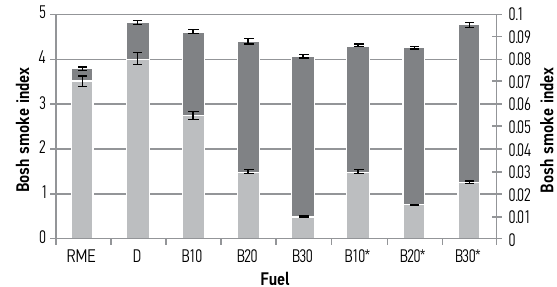
Fig. 4 . The dependence of PAH emissions on fuel composition at the engine rotation speeds of: